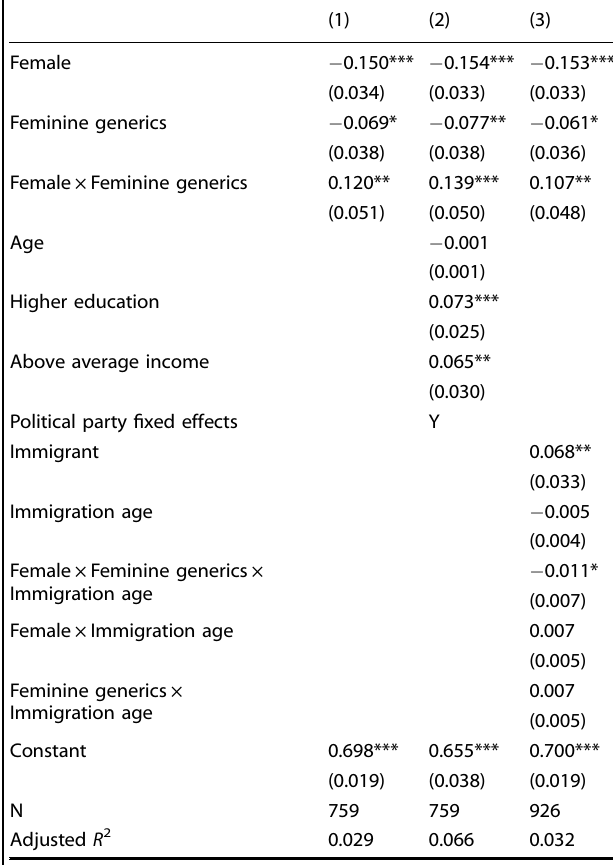
Table 2. OLS regression models predicting grades in